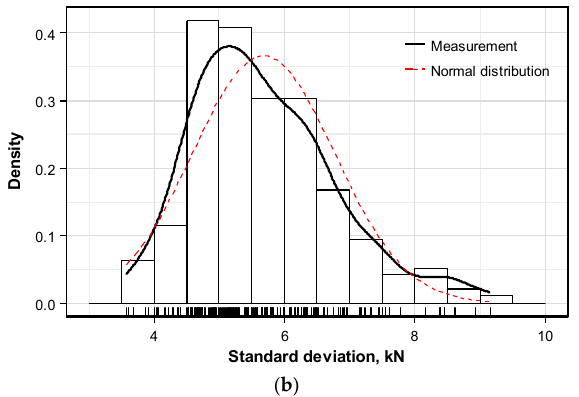
Figure 10. Distribution of standard deviation of prestress force per anchor head: ( a ) Whole set of measured data; ( b ) Measured of data excluding outliers.